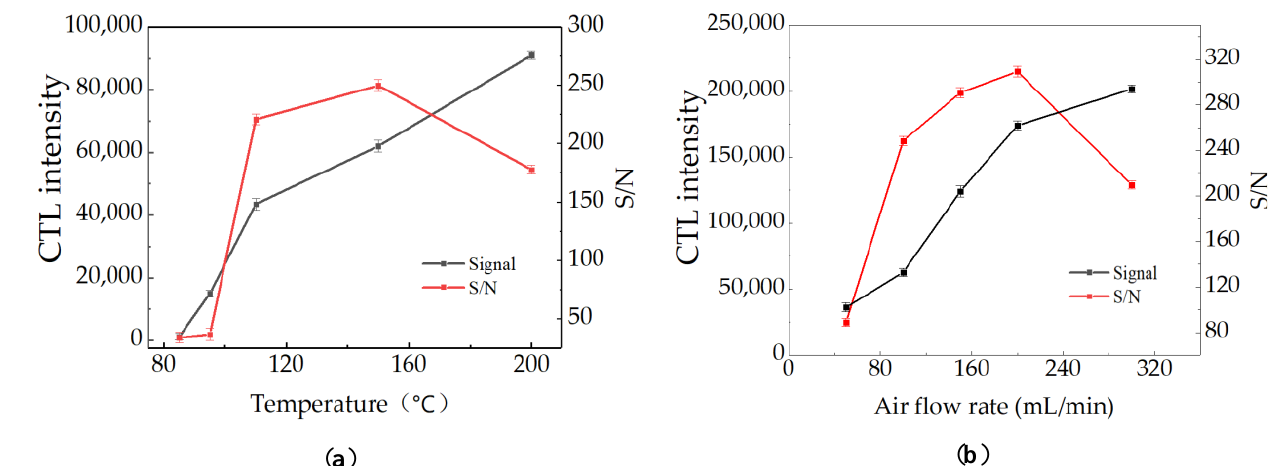
Figure 4. Effects of ( a ) working temperature and ( b ) airflow rate on CTL intensity and the S/N value: ( a ) detecting concentration: 87 ppm; airflow rate: 100 mL/min; ( b ) detecting concentration: 87 ppm; detecting temperature: 150 °C.